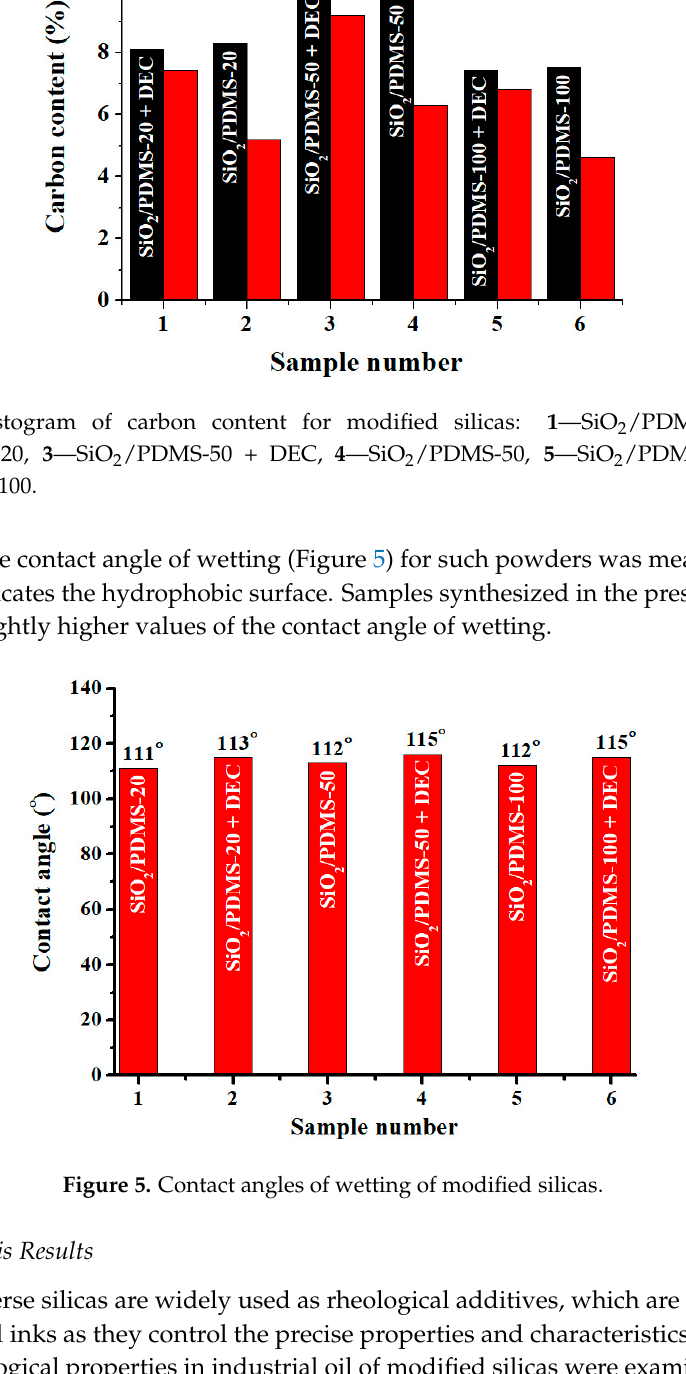
Figure 5. Contact angles of wetting of modified silicas.